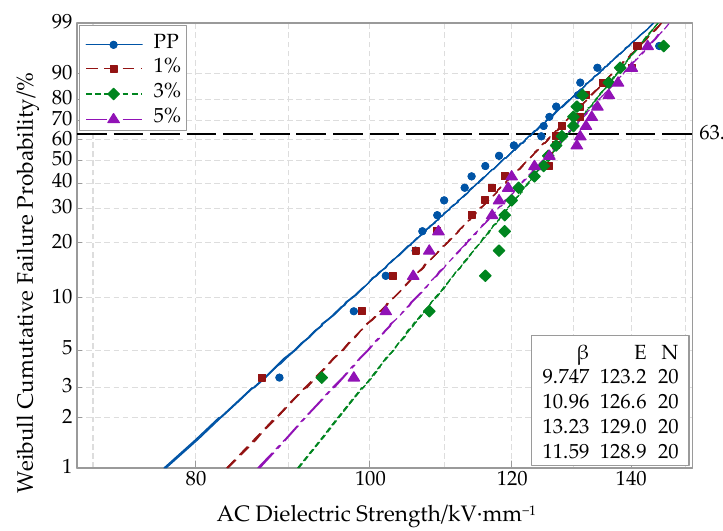
Figure 4. Weibull distribution curve of AC breakdown strength of various samples.